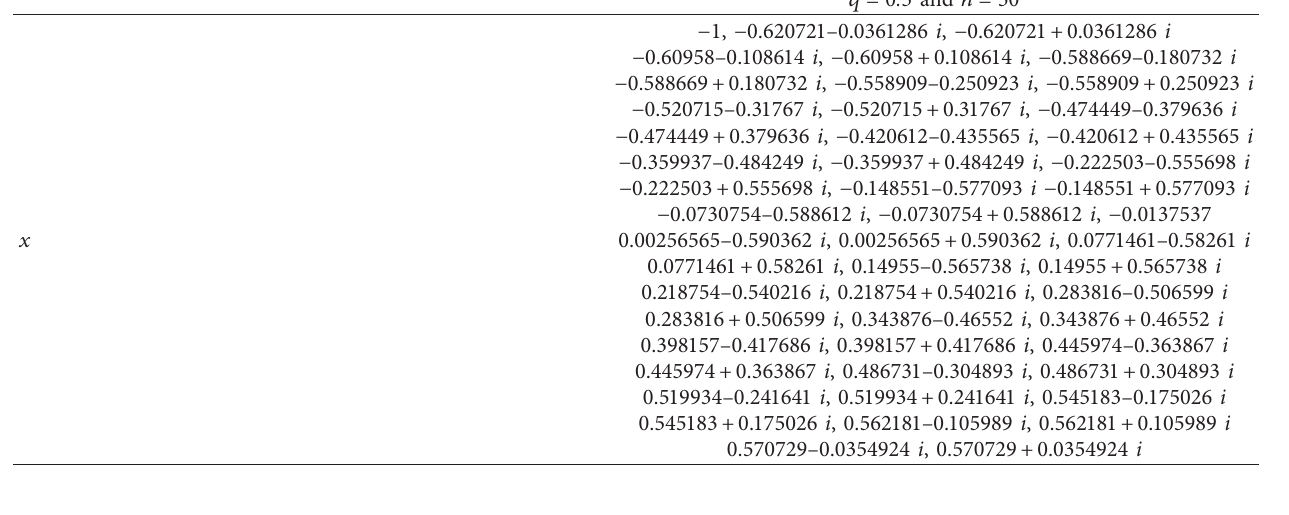
( x ) for n � 10 , 30 , 50. n, 0 . 5 ( x ) . 50 , 0 . 5